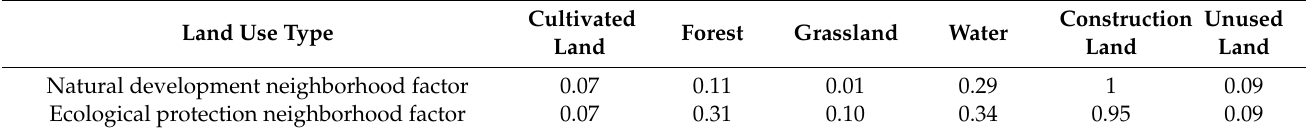
Table 1. Neighborhood factor